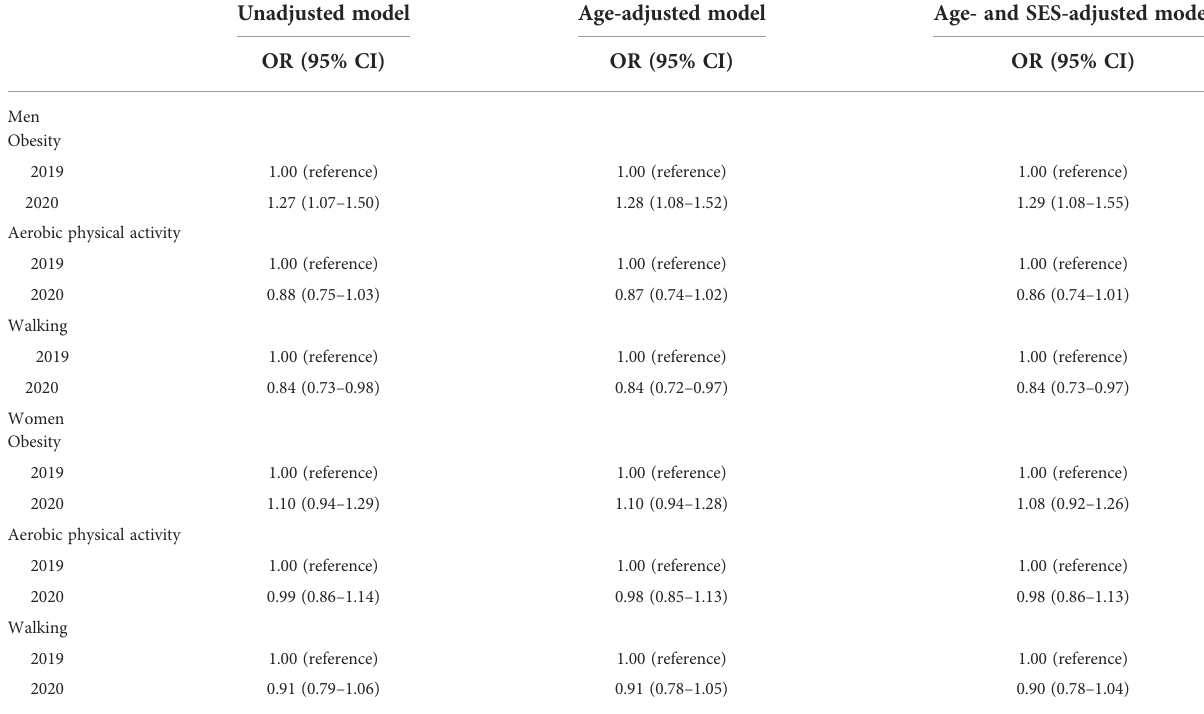
TABLE 3 Multiple logistic regression model for obesity and aerobic physical activity in 2020 compared to